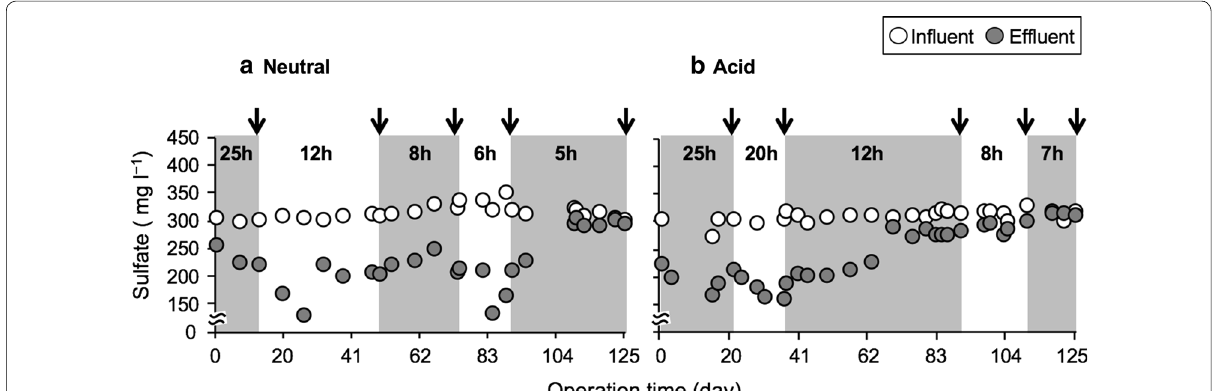
Fig. 1 Effect of hydraulic retention time (HRT) on sulfate concentration during 125-day operation under the neutral ( a ) and acid ( b ) conditions. The HRT was changed from 25 to 12 h, 8 h, 6 h, and 5 h under the neutral condition, and to 20 h, 12 h, 8 h, and 7 h under the acid condition. Symbols influent, open circles ; effluent, gray circles . Arrows indicate the sampling points for depth direction analysis in respective